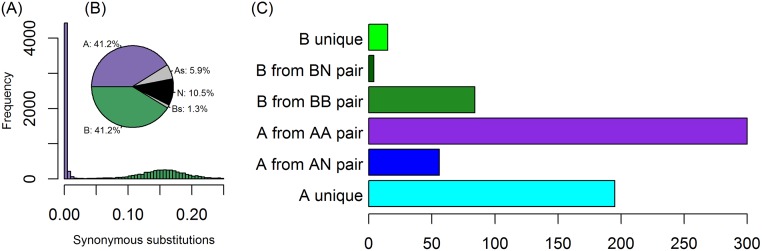
(A) Histogram of the distribution of synonymous site divergence (KS) values for 10,087 Z. parabailii ATCC60483 genes compared to their closest Z. bailii CLIB213T homologs. (B) Pie chart showing the proportions of genes classified into each category. The 2 largest categories refer to A-genes and B-genes that are in A:B pairs. “N” means genes for which no Z. bailii homolog was found or KS to Z. bailii exceeded 0.25. “As” and “Bs” indicate other A-genes and B-genes, as analyzed in panel C. (C) Breakdown of the numbers of genes assigned to the A- or B-subgenomes that are not in A:B pairs. See S1 Data for category counts and KS values for each gene.